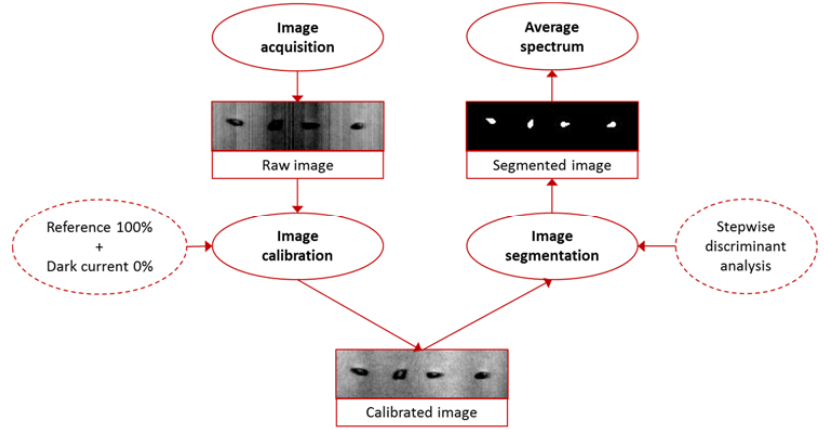
Figure 1. Description of the procedure carried out for each sample from the raw hyperspectral image acquisition until obtaining the average spectrum.